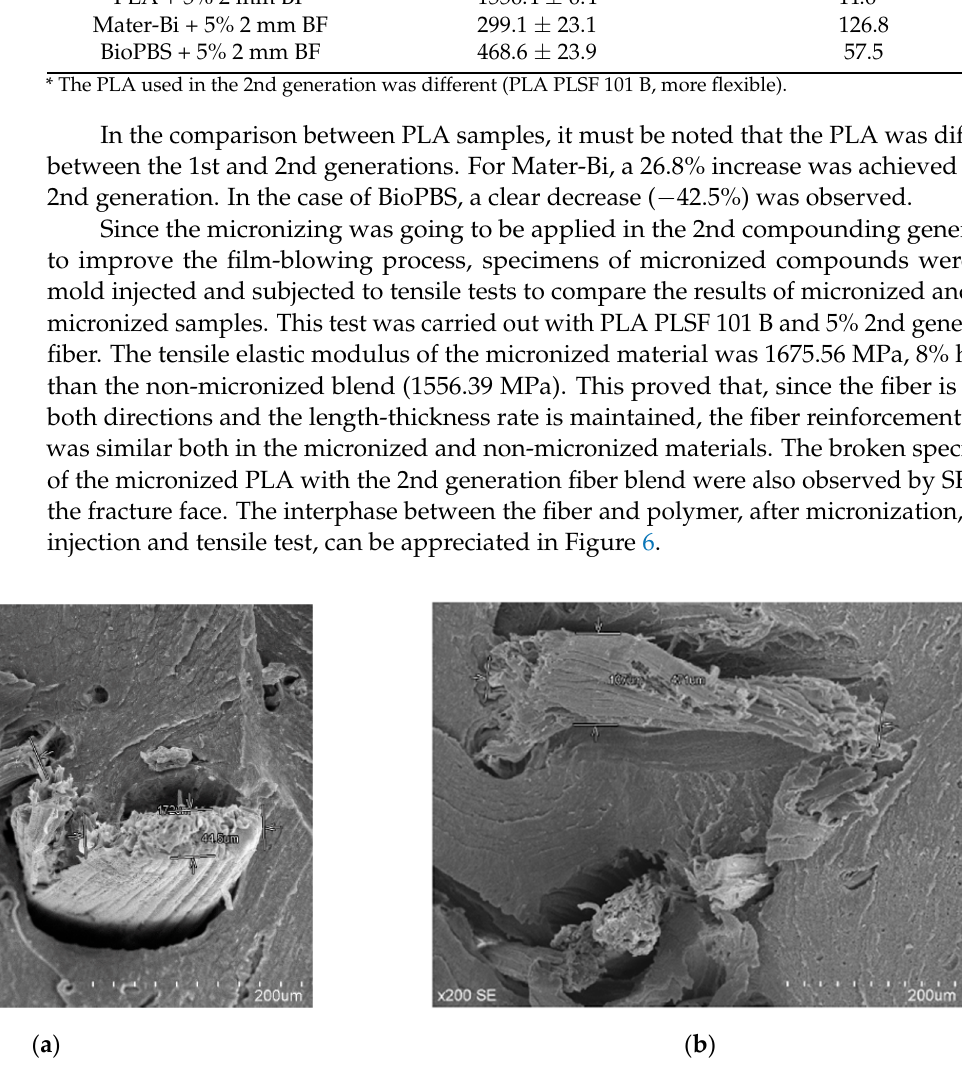
Figure 6. Micronized PLA with 5% 2nd generation fiber interphase, SEM micrography, ( a ) ×250, ( b ) ×200.